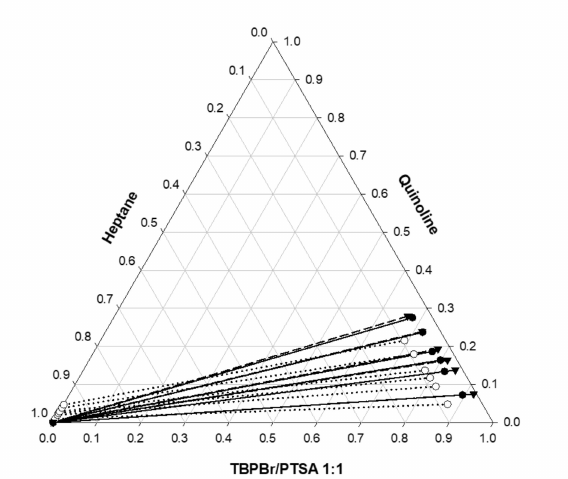
Figure 8. Ternary phase diagram for TBPBr / PTSA + quinoline + heptane at 25 ◦ C. The solid line represents experimental data, dotted line represents COSMO-RS prediction, and the dashed line represents non-random two-liquids (NRTL) LLE prediction.